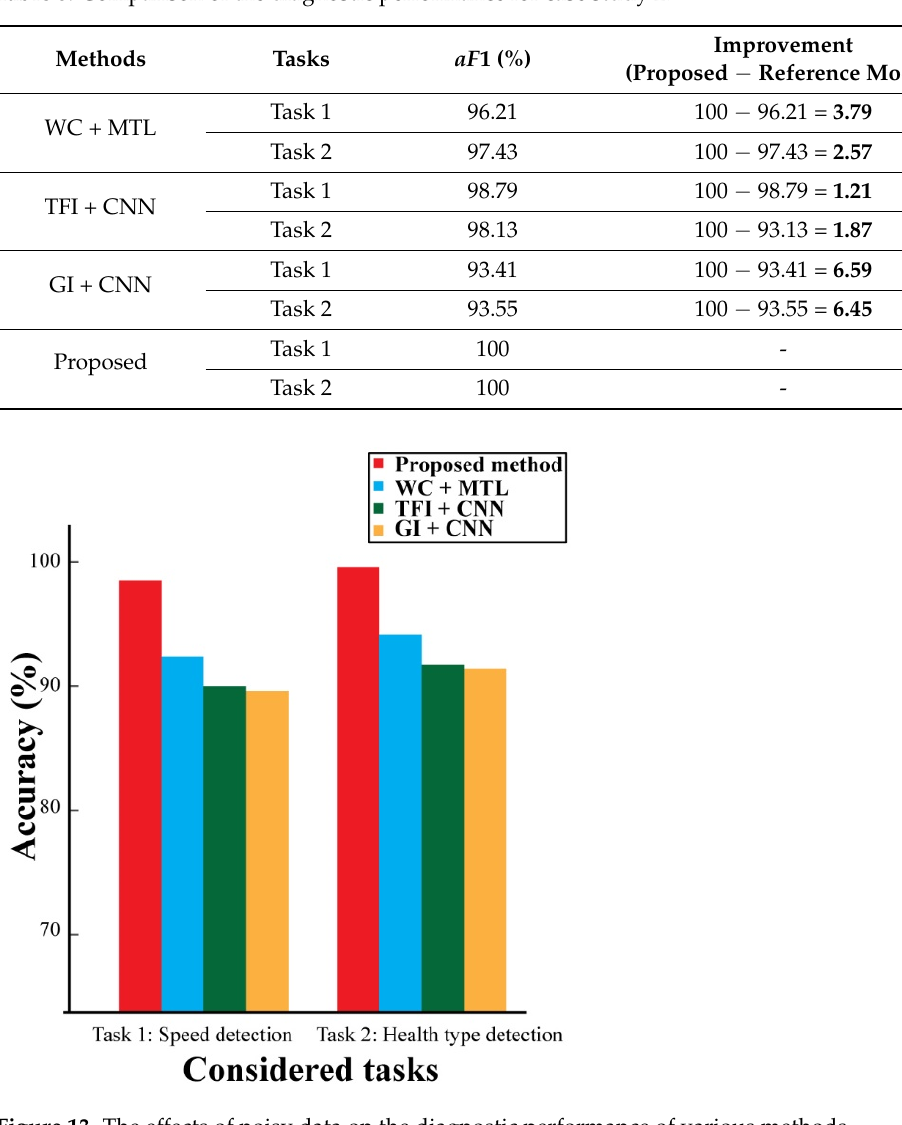
Table 8. Comparison of the diagnostic performance for case study 2.